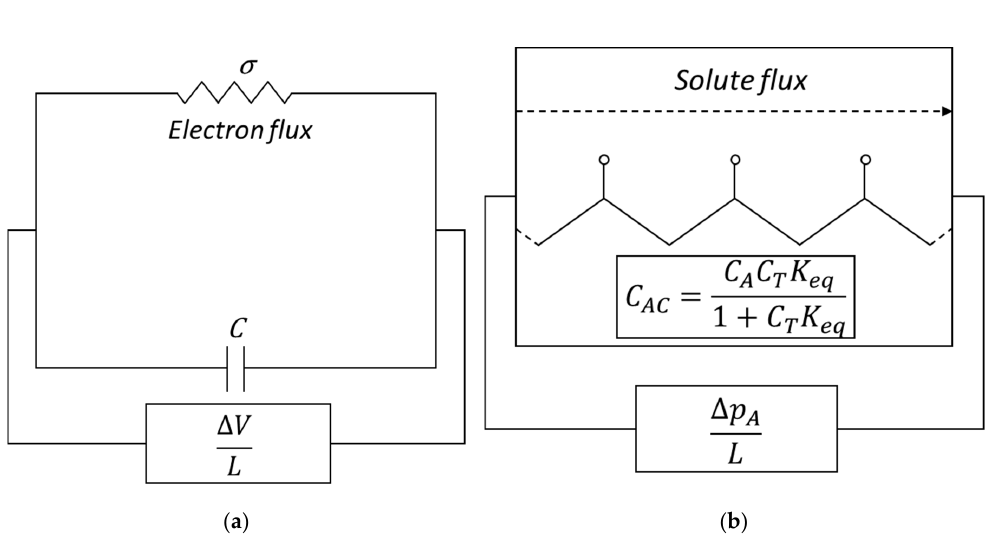
Figure 15. Analogies between RC parallel circuit and fixed sites carrier systems. ( a ) Parallel configuration of single RC circuit; ( b ) fixed sites carrier systems. Analogies among driving forces and capacitance effects according to Table 1.